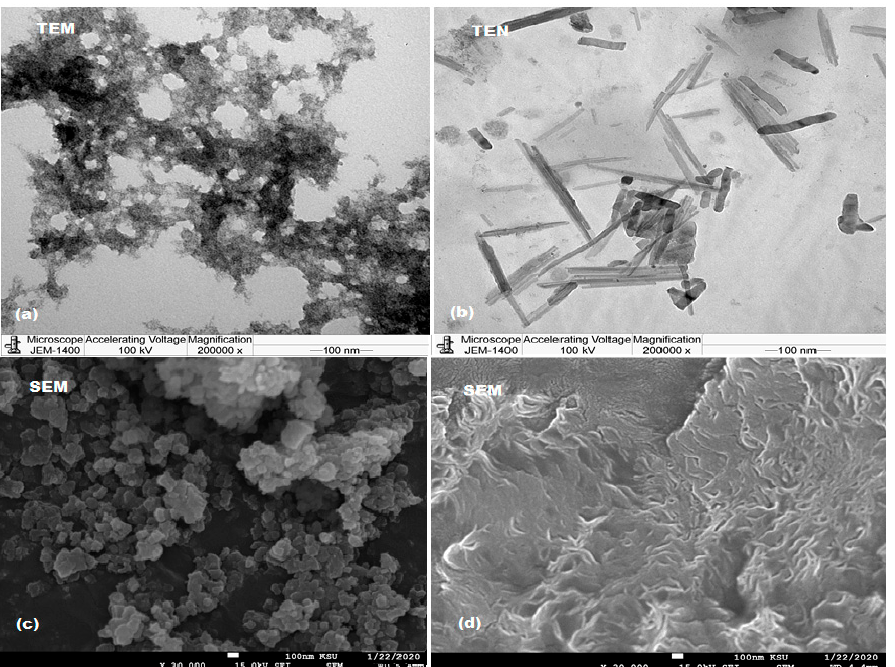
Figure 6. TEM ( a , b ) and SEM ( c , d ) images of green synthesized NiONPs and MnO 2 NPs using Mentha spicata and Malus domestica peel extracts, respectively.